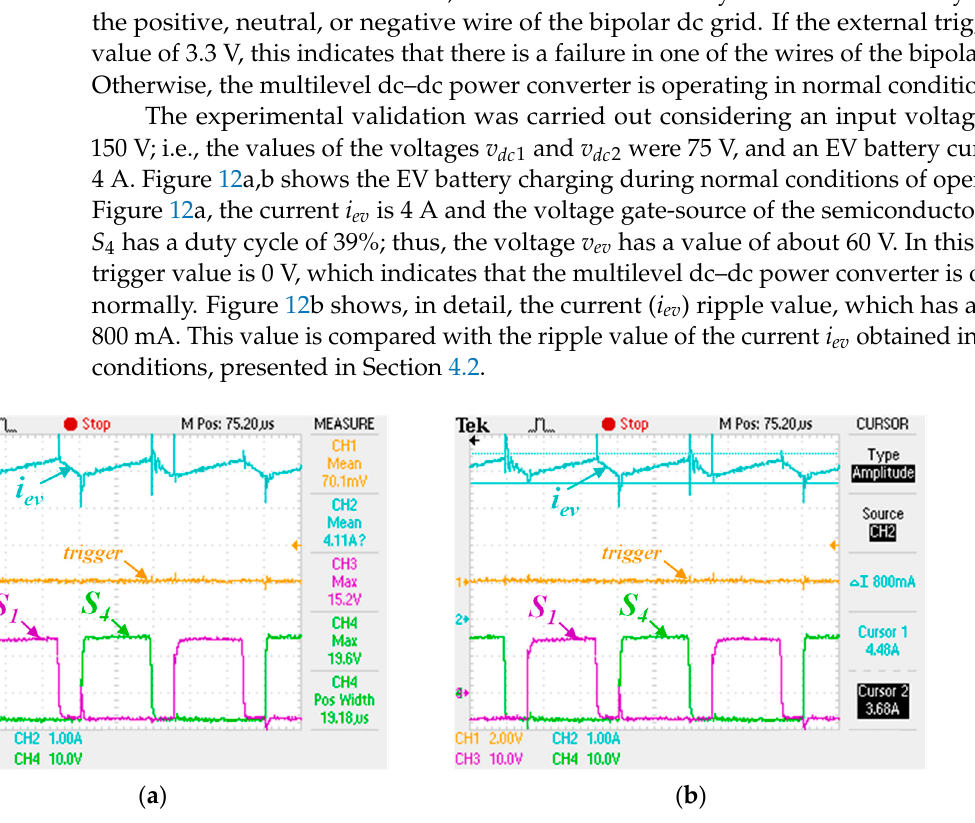
Figure 12. Steady-state operation of the multilevel dc–dc converter under normal conditions: ( a ) an i ev of 4 A and a duty cycle of 39% for semiconductors S 1 and S 4 ; ( b ) an i ev ripple value of 800 mA and a trigger value of 0 V.